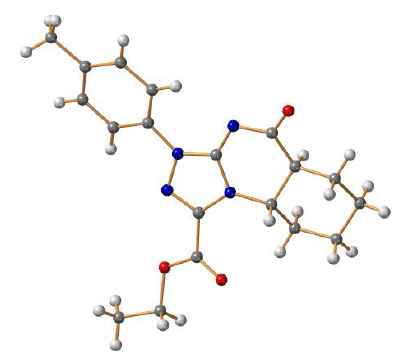
Figure 2. TELP image of 5b at 50% probability level.